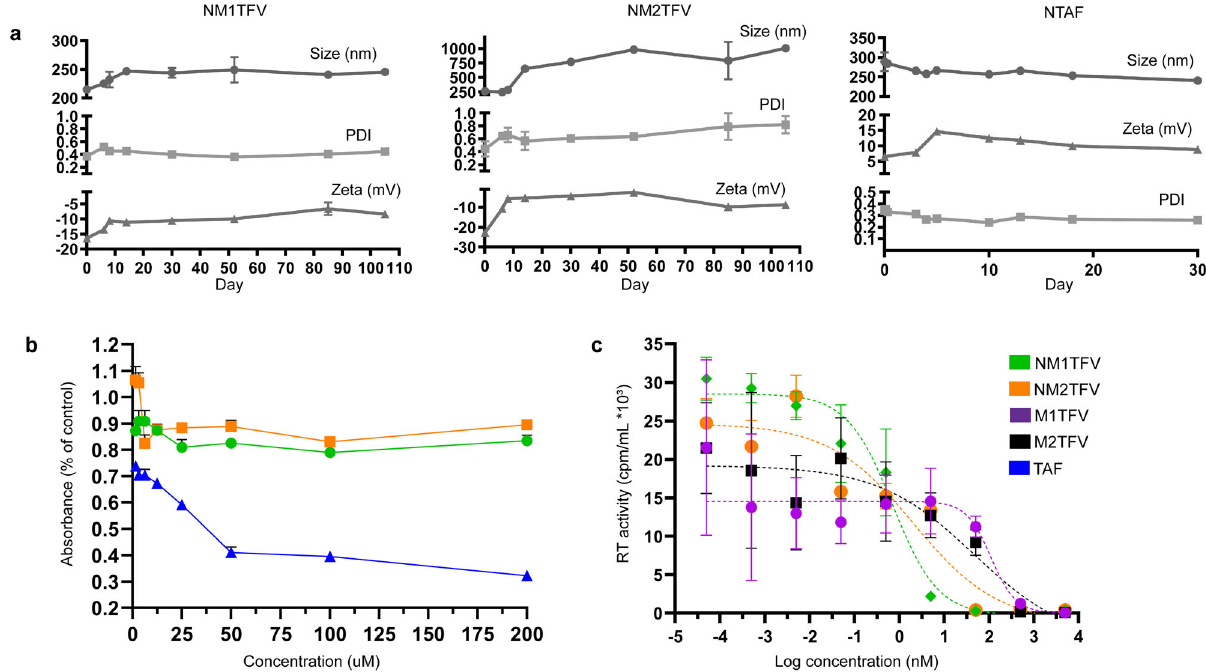
Fig. 2 Nanoformulation of TFV ProTides. Nanoformulations were synthesized by high-pressure homogenization using poloxamer 407 (P407) as the excipient for NM1TFV/NM2TFV, or P407 and PEG 3350 as excipients for NTAF. a Formulation stability at 25 °C (up to 110 days) was measured by particle hydrodynamic diameter (size), polydispersity index (PDI), and zeta potential as determined by dynamic light scattering (DLS). Data were independently reproduced three times. b Cell viability was assessed in MDM by MTT assay 8 h after NM1TFV, NM2TFV, or TAF treatment over a range of concentrations (1 – 200 µ M). Results were normalized to untreated control cells. All results are shown as the mean ± SEM of four replicates. c IC 50 of M1TFV, M2TFV,